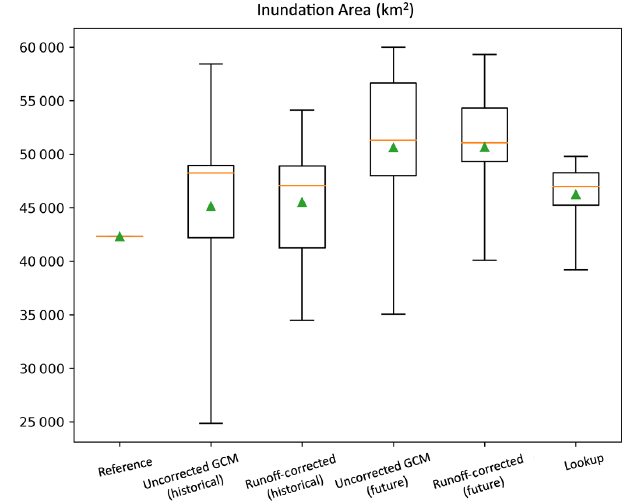
Figure 7. Box plot of inundated-area (km 2 ) estimates near the Chao Phraya River obtained using the runoff-correction method and lookup method. Whiskers show minimum and maximum values, boxes show 25th and 75th percentile values, orange lines show the median (50th percentile) value, and green triangles show the aver- age